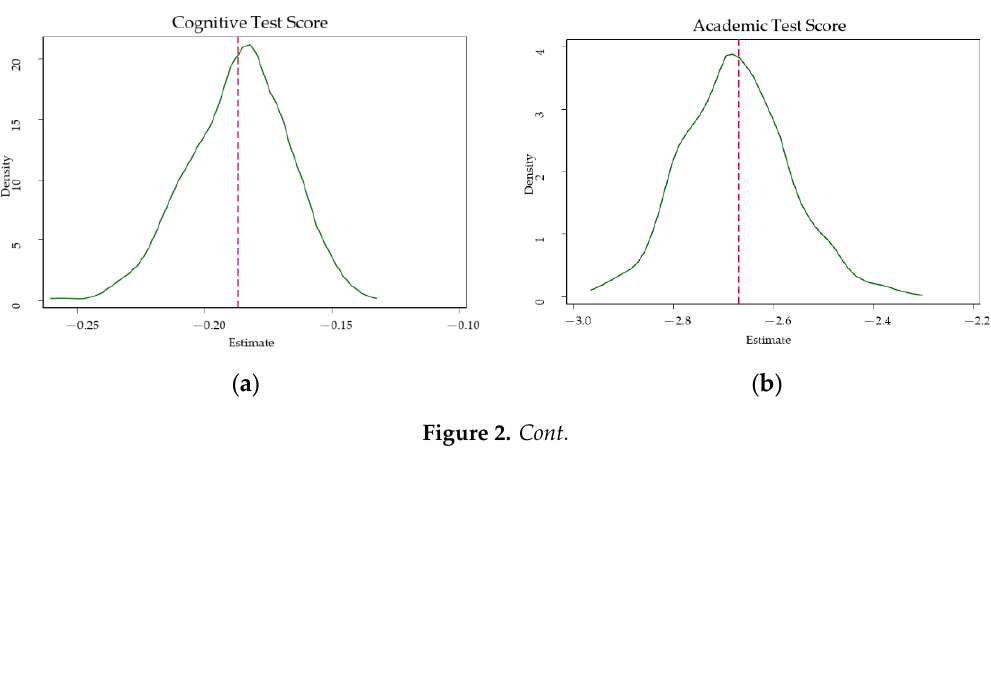
Table 6. Effects of parental absence on test scores of different subjects.